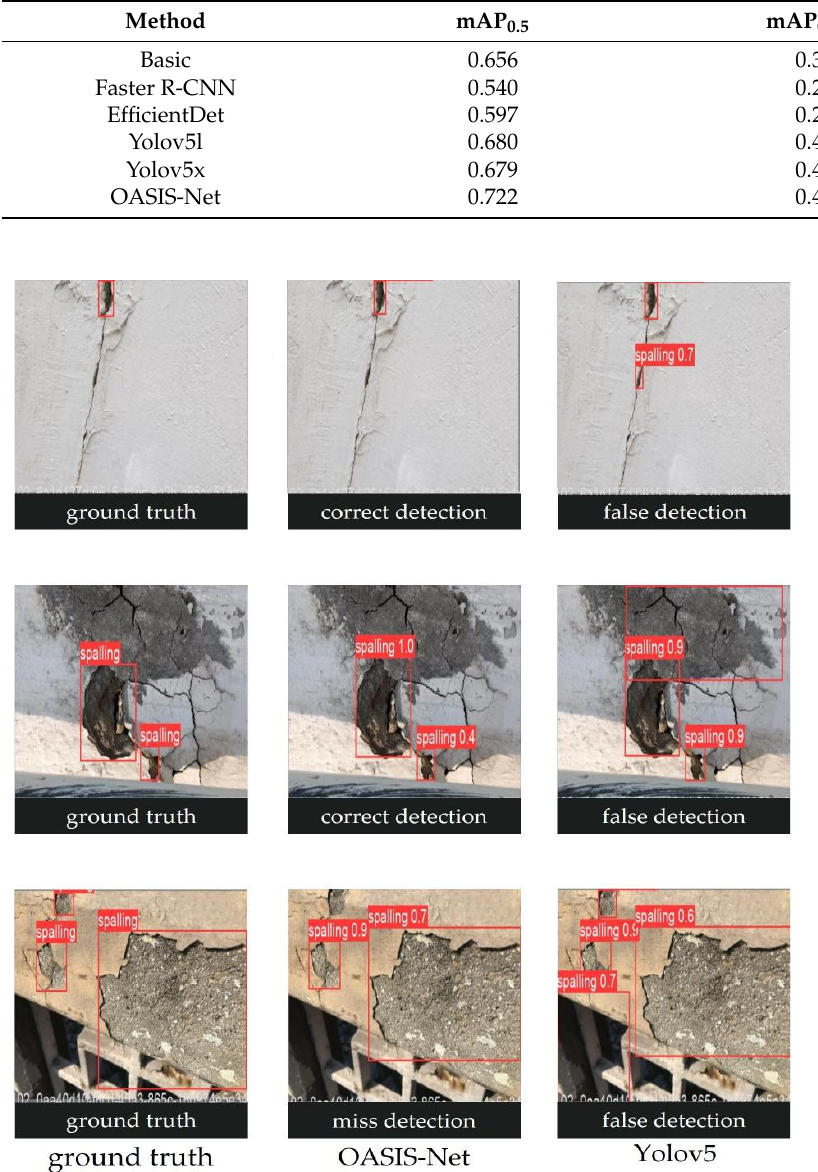
Figure 17. Visual comparison of spalling detection results. Table 3. Comparison of the mean average precision (mAP) of the spalling detection.